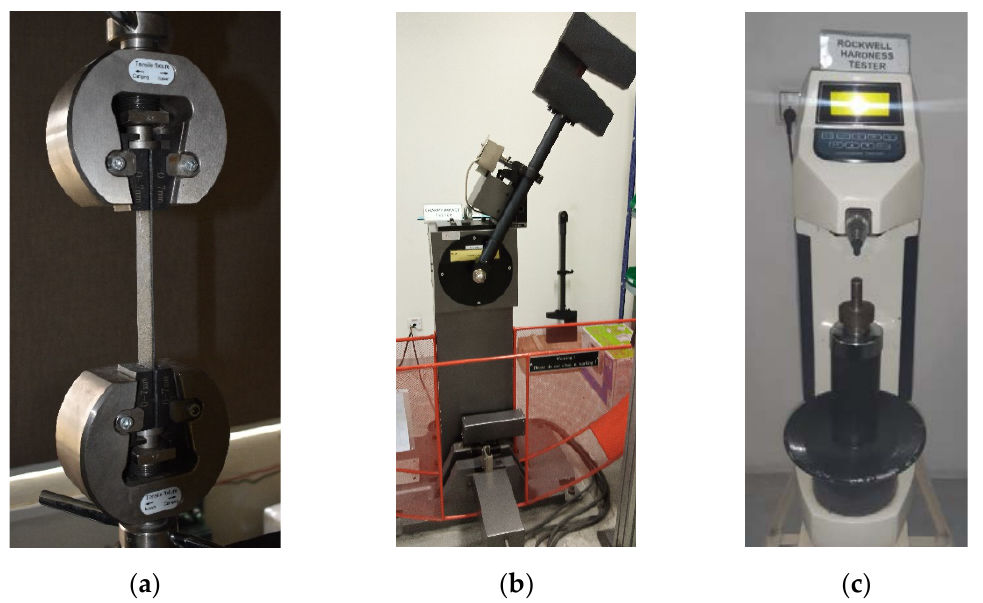
Figure 5. ( a ) Universal tensile testing machine M/s Hualong, Shanghai, China HLE 300 kN. ( b ) Charpy impact toughness testing machine M/s Time Group Inc., Beijing, China Model No. JBS300. ( c ) Rockwell hardness testing machine M/s Time Group Inc., Beijing, China Model No. TH300 used for mechanical testing.